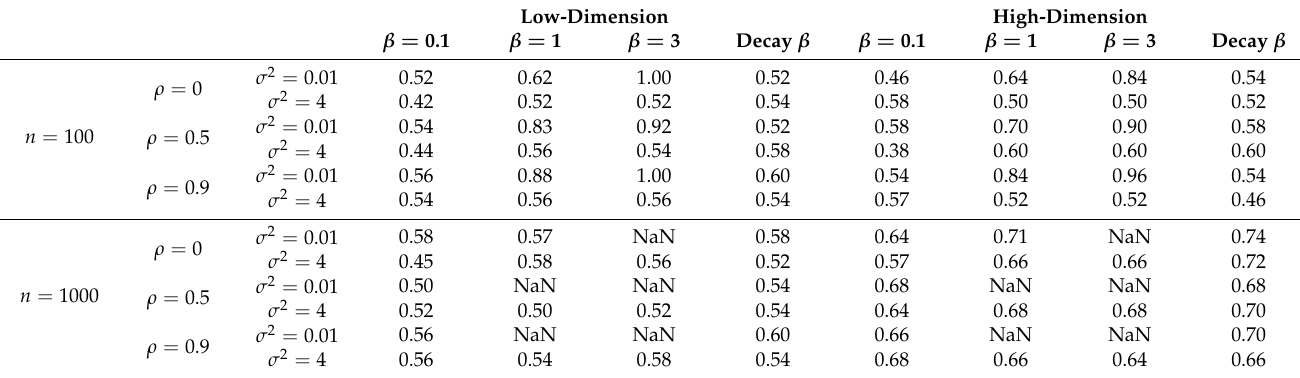
Table A5. Regression estimation: probability of λ min doing better, AR(1) correlation. Low-Dimension